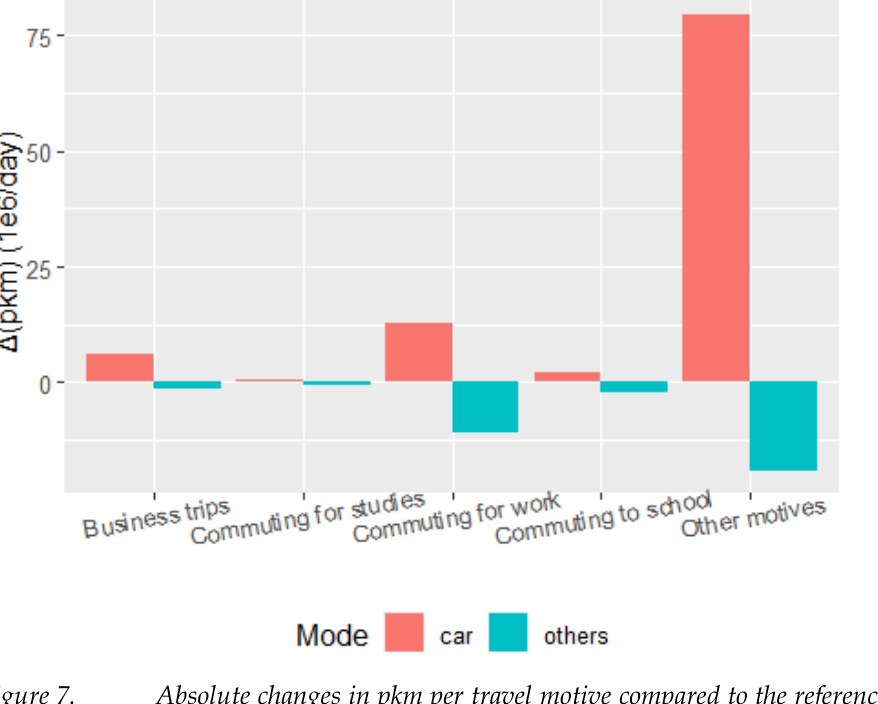
Figure 7. Absolute changes in pkm per travel motive compared to the reference scenario (for VOT = 0.06